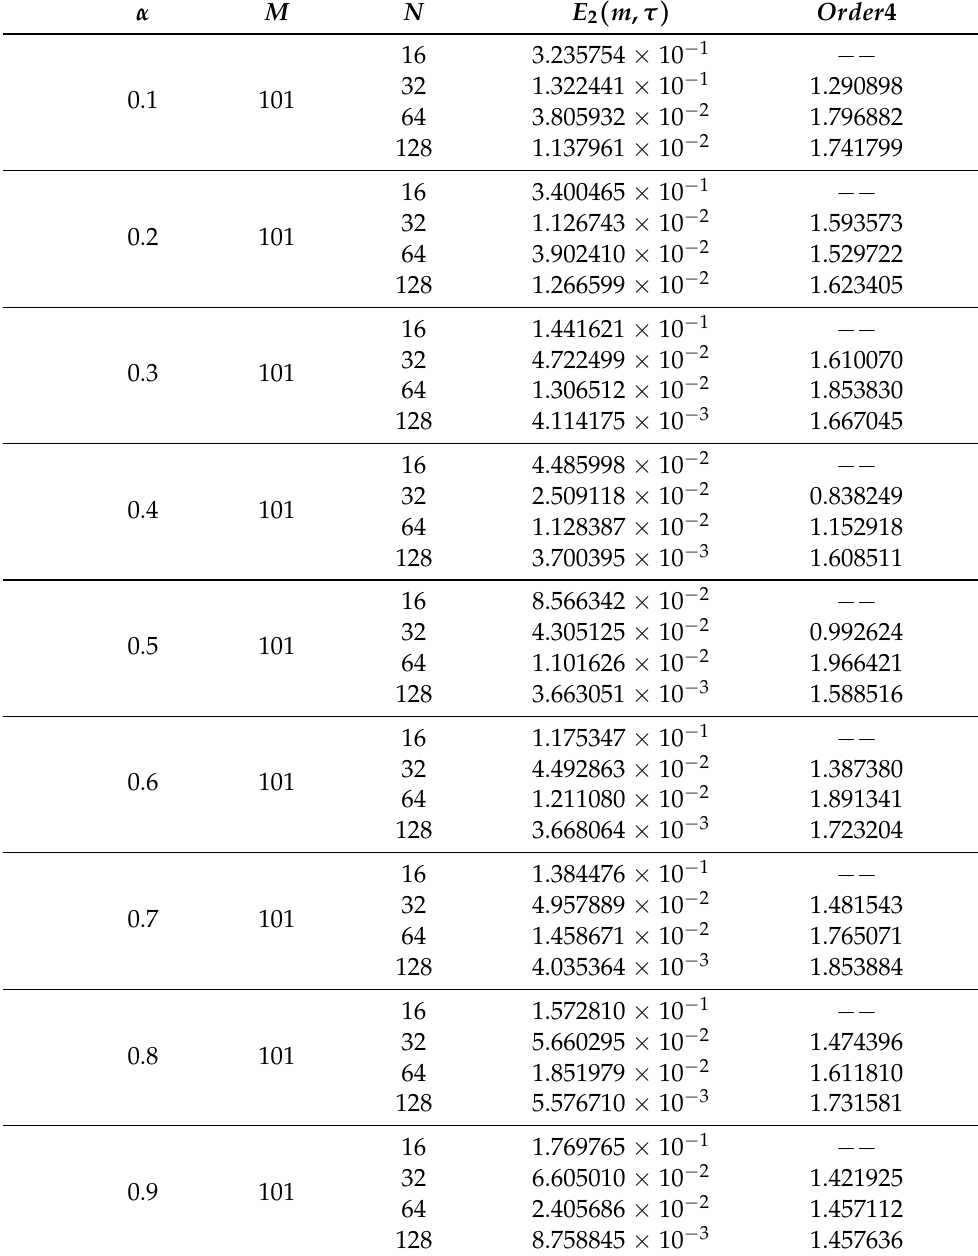
Table 9. Numerical error and temporal convergence order of HASC-N difference scheme for Example